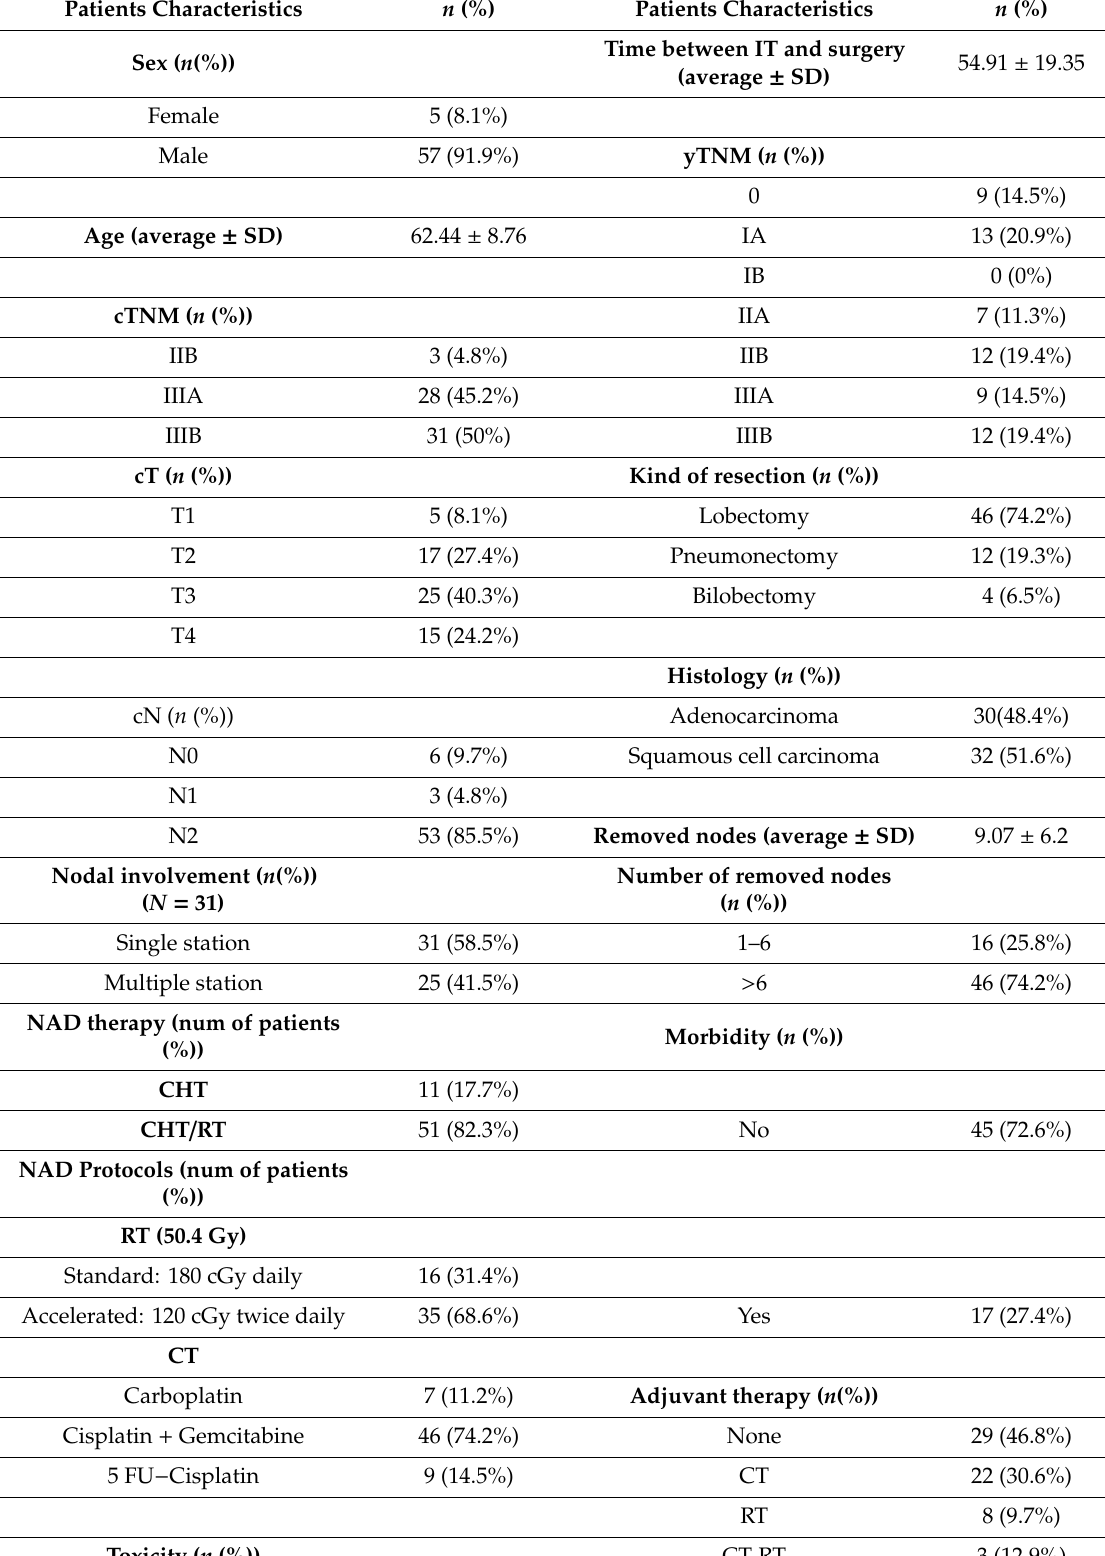
Table 1. Main sample clinical, surgical and pathological characteristics of the study group ( n = 62). Patients